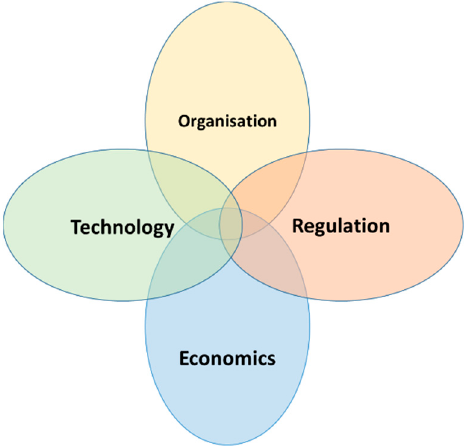
Figure 1. Key forces that must be taken into consideration when introducing process technologies to biologics manufacturing. biologics